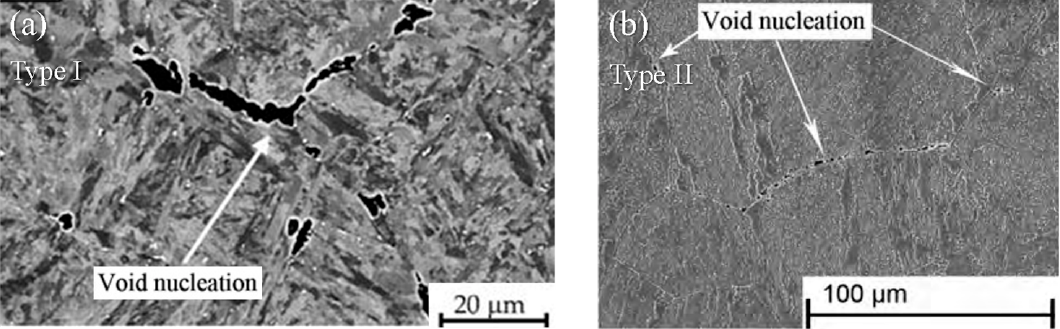
Figure 5. Nucleation and coalescence of cavities under creep conditions at ( a ) the triple junction (Type I, e.g., 9Cr1Mo-NbV [50]), and ( b ) the grain boundaries perpendicular (or almost perpendicular) to the loading direction (Type II, e.g., 25Cr2NiMo1V [51]).